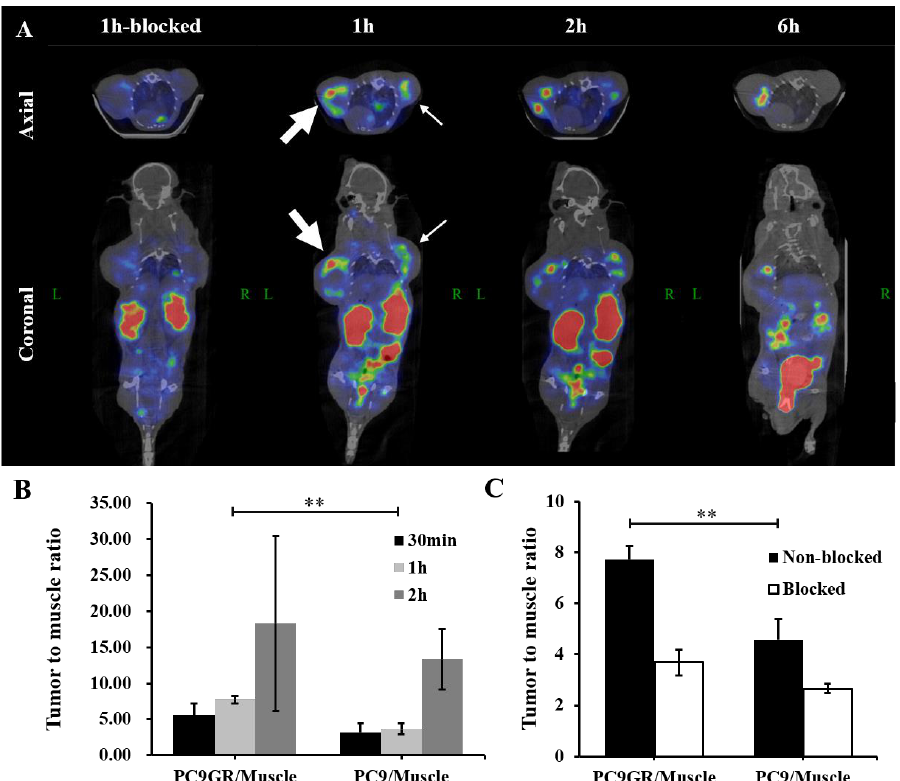
Figure 9. ( A ) Dynamic imaging of 99m Tc-HYNIC-ADH-1 micro-SPECT/CT in mouse model at different times (thick arrow: PC9GR tumor, thin arrow: PC9 tumor). ( B ) Tumor (PC9GR and PC9) to muscle ratio at 30 min, 1 h and 2 h based on ROI analysis. Since no radioactivity was found in the muscle at 6 h, the data of the 6 h group were not included. ( C ) Tumor (PC9GR and PC9) to muscle ratio of non-blocked group mice and blocked group mice at 1 h based on ROI analysis. (* P < 0.05, ** P < 0.01).